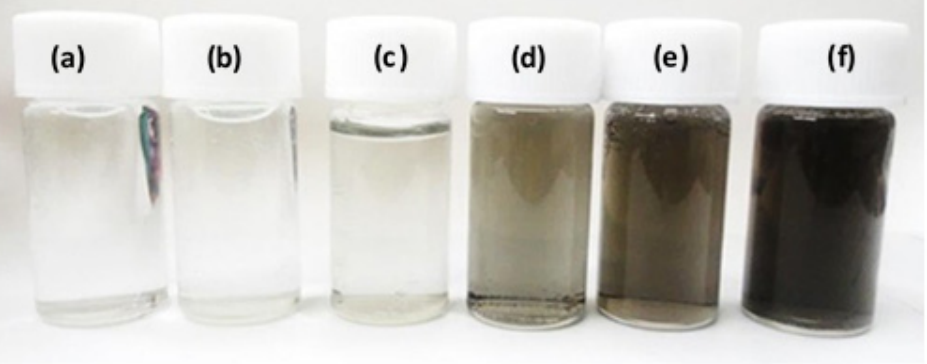
Figure 8. Solution products after the pulsed discharge plasma treatments: 0.1 ( a ), 1.0 ( b ), 1.5 ( c ), 2.0 ( d ), 3.0 ( e ), and 4.0 MPa ( f ), respectively [40]. At room temperature (25 °C), the argon solubility is around 0.252 × 10 − 4 at a pressure